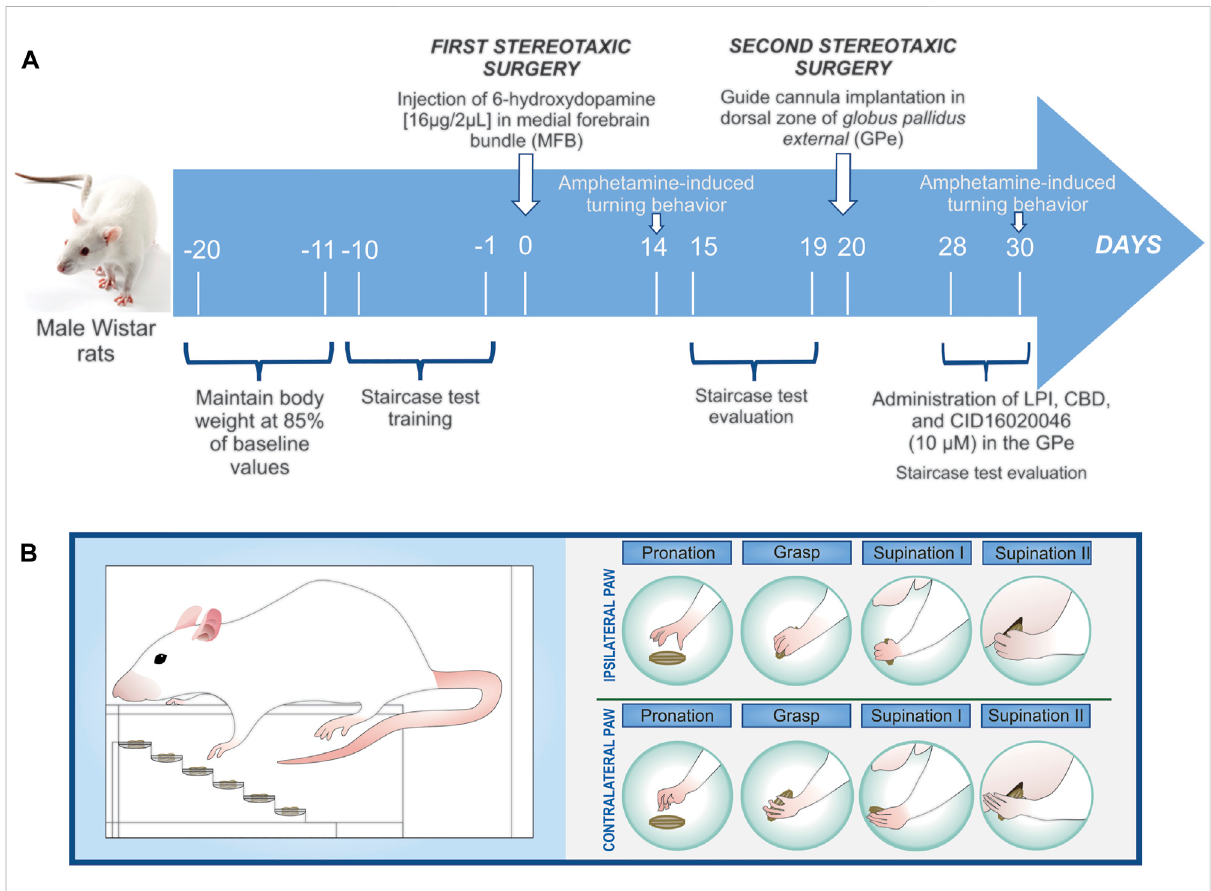
neurons (the fi rst stereotaxic surgery). Amphetamine-induced turning behavior was evaluated twice, on the 14th and 30th days post-lesion. Once the guide cannula had been implanted on the 15th day post-lesion (the second stereotaxic surgery), eight groups were obtained: vehicle +